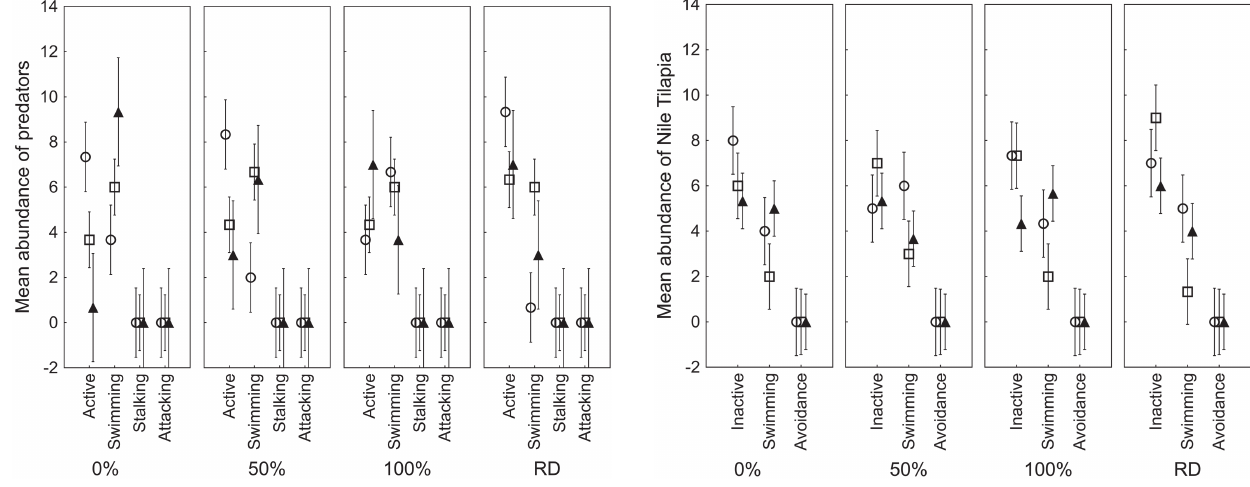
Fig. 8 . Activity (inactive, swimming and avoidance) by the Nile Tilapia (mean ± SD) in the tanks with Pseudoplatystoma corruscans (white circles), Salminus brasiliensis (white squares) and Brycon orbignyanus (black triangles), for 0%, 50%, 100% and RD treatments. The three-way ANOVA for these data suggested interaction (P =0.029) among species, structural complexity and activity. The avoidance activity was not